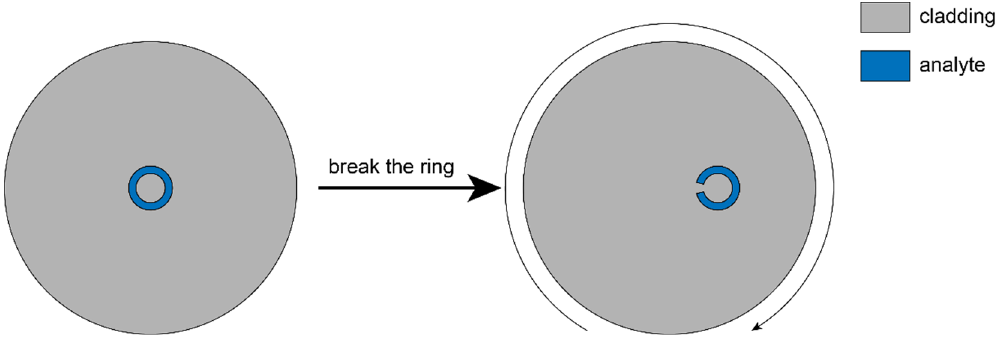
Figure 1. Cross-section of an imaginary fiber ( left ) and the proposed fiber ( right ). The curved arrow indicates the twist direction.